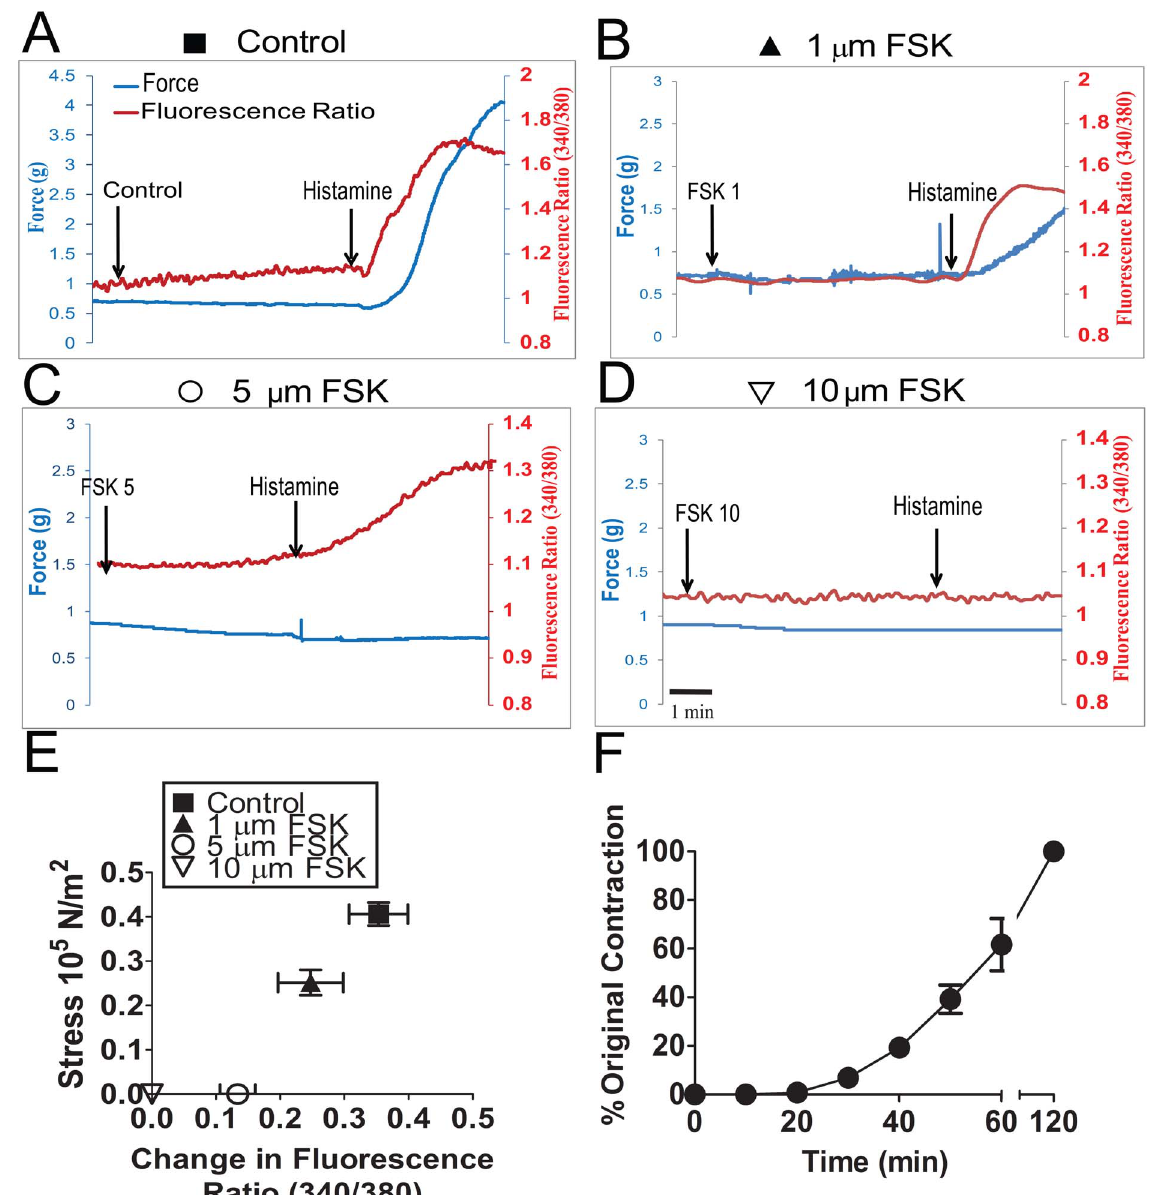
Figure 1. Preincubation with forskolin suppressed histamine-induced force in porcine coronary artery. PCA rings were suspended in a muscle bath and equilibrated in Kreb’s bicarbonate buffer for 2 h. Panel A–D: Representative force and intracellular calcium tracings of rings pretreated with either nothing, 1, 5, or 10 m M forskolin followed by 5 m M histamine. Panel E: Comparison of concurrent change in flourescent ratio (340/380 nm) to Stress (N/m 2 ) from histamine-induced contraction with various doses of forskolin added as a pretreatment. Panel F: Reversibility of Forskolin-mediated force suppression. Contraction to 5 m M histamine was assesed after washing off the 5 m M forskolin. The sample was rechallanged with histamine every 10 min for the first 50 min to determine recovery of contraction. Samples were also challenged after two hours of washing which resulted in the full recovery of histamine induced contraction.